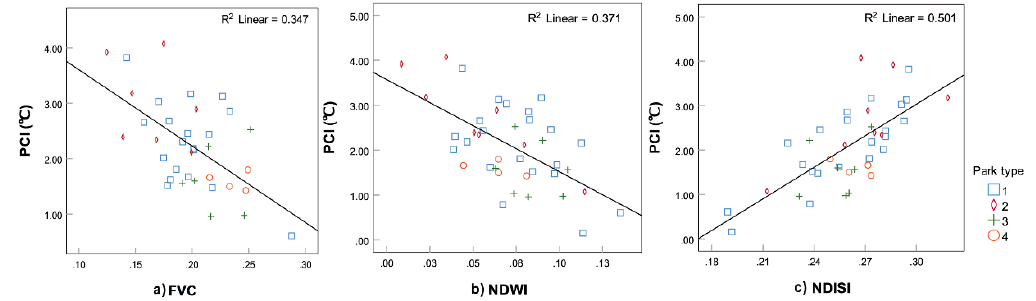
Figure 7. Regression analysis between the PCI and the impact factor of park surrounding area (500m buffer). ( a ) surrounding FVC; ( b ) surrounding NDWI; ( c ) surrounding NDISI, park type: LST range (29–30 °C ) based selection of 43 parks: 1-urban park; 2-theme park; 3-street park; 4-linear park.